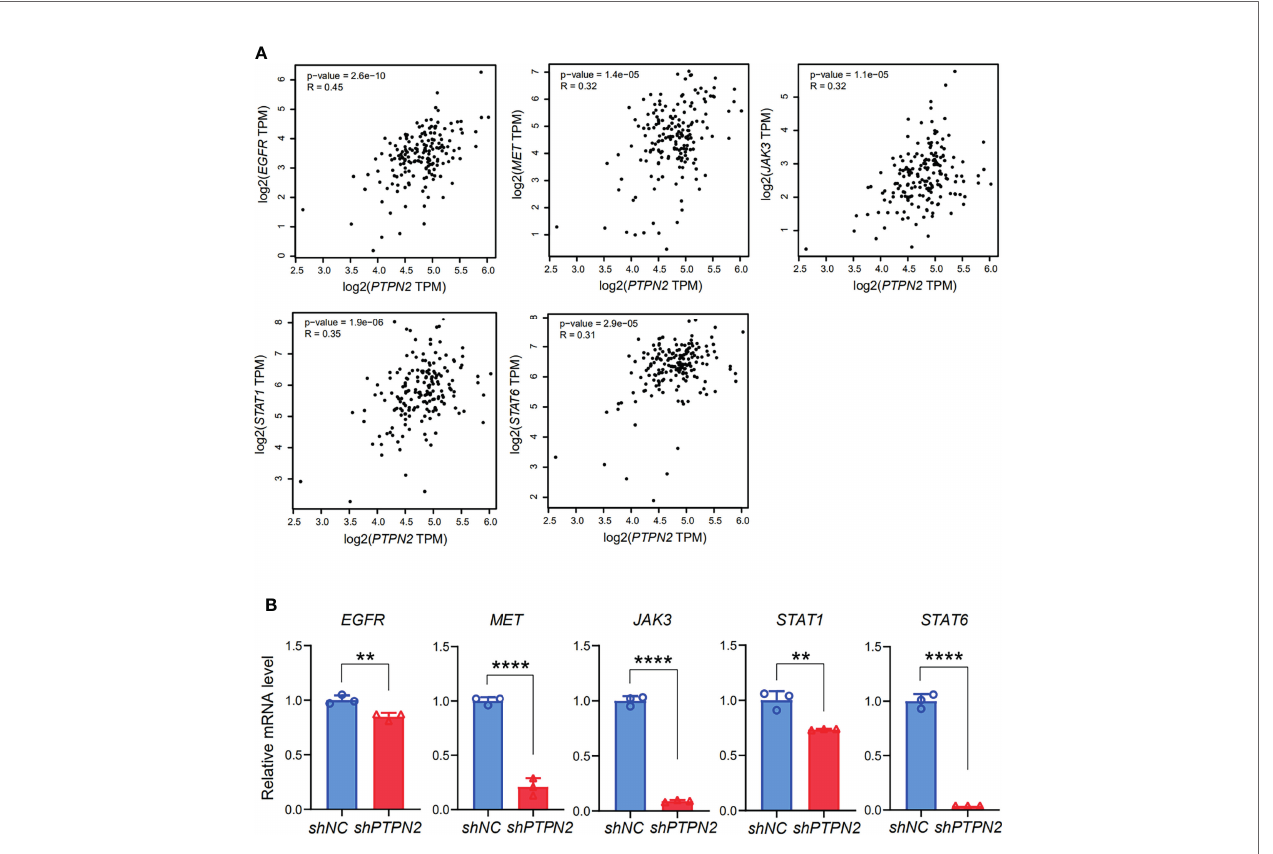
FIGURE 11 | Identi fi cation of a series of targets of PTPN2 . (A) Correlation analysis of PTPN2 expression and key genes expression in PAAD. (B) RT-qPCR analyze the relative expression of EGFR , MET , STAT1 , JAK3 and STAT6 in sh PTPN2 or vector-transfected PANC-1 cells. **p < 0.01, ****p <